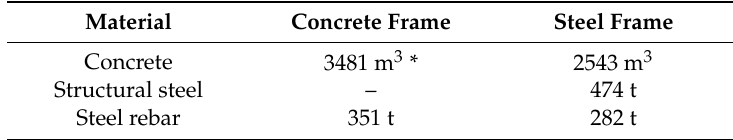
Table 5. Total amount of each